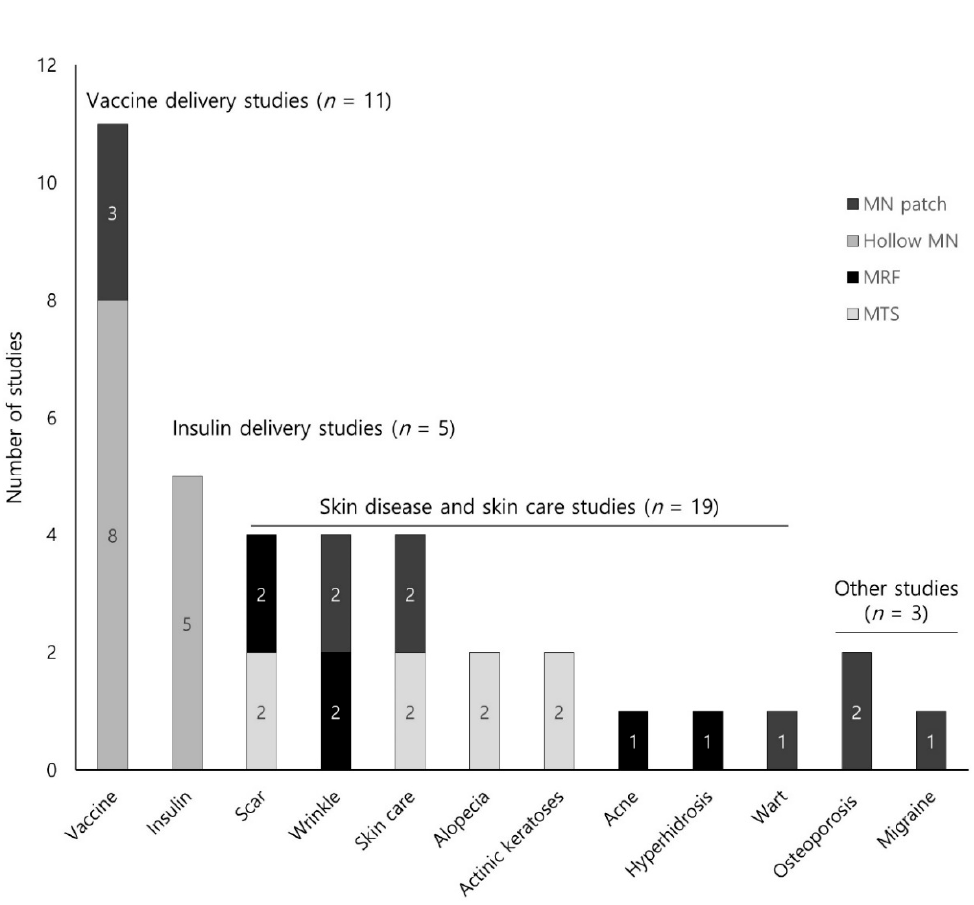
Figure 2. Number of studies included by diseases or microneedles types.